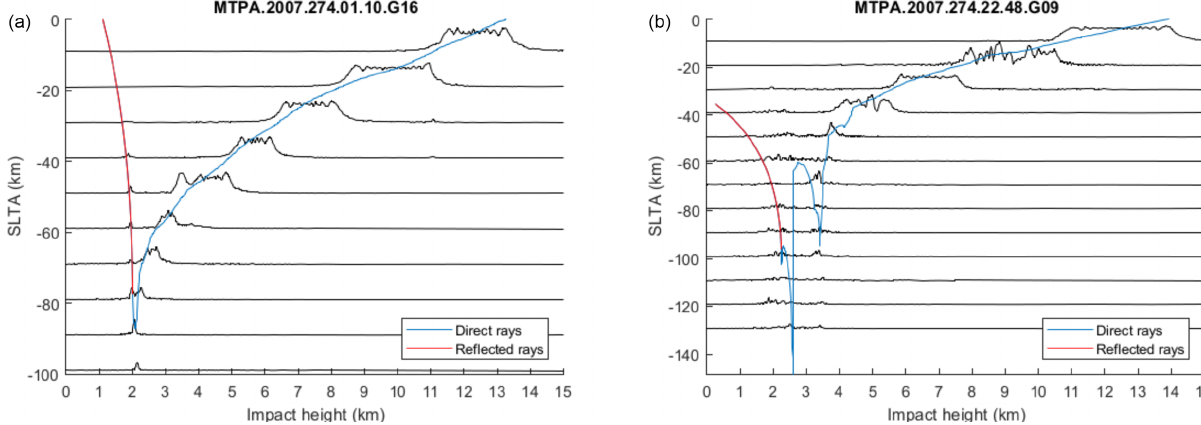
Figure 1. Using a sliding window for the signal yields PM amplitudes that correspond to the reflection model. Panel (a) shows a case with weak refractive gradients; panel (b) shows a case with strong refractive gradients.